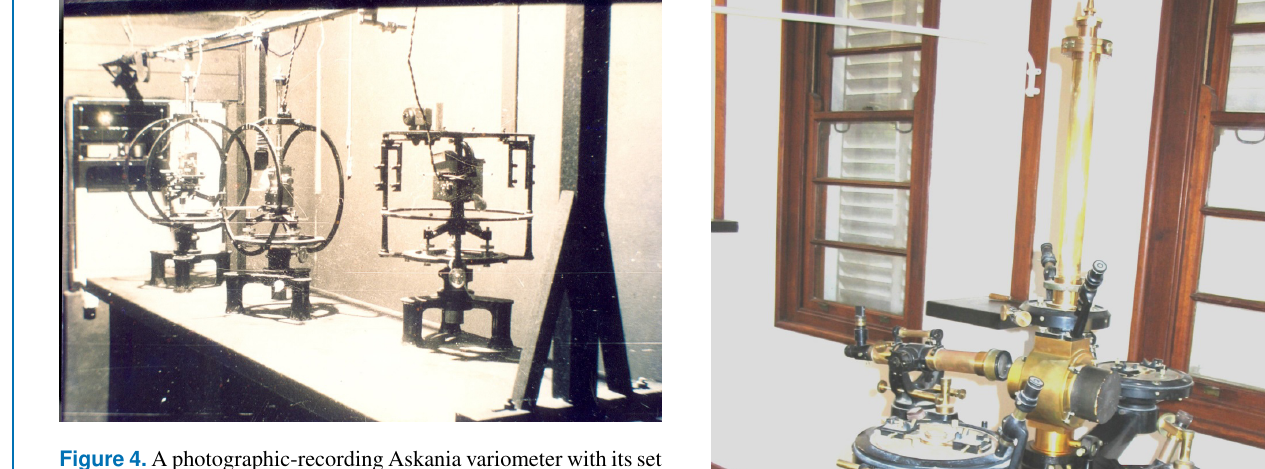
Figure 4. A photographic-recording Askania variometer with its set of Helmholtz coils.